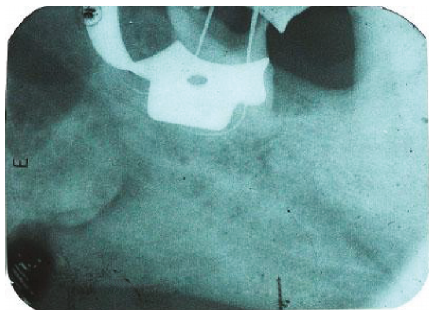
Figure 2: Working length radiograph.